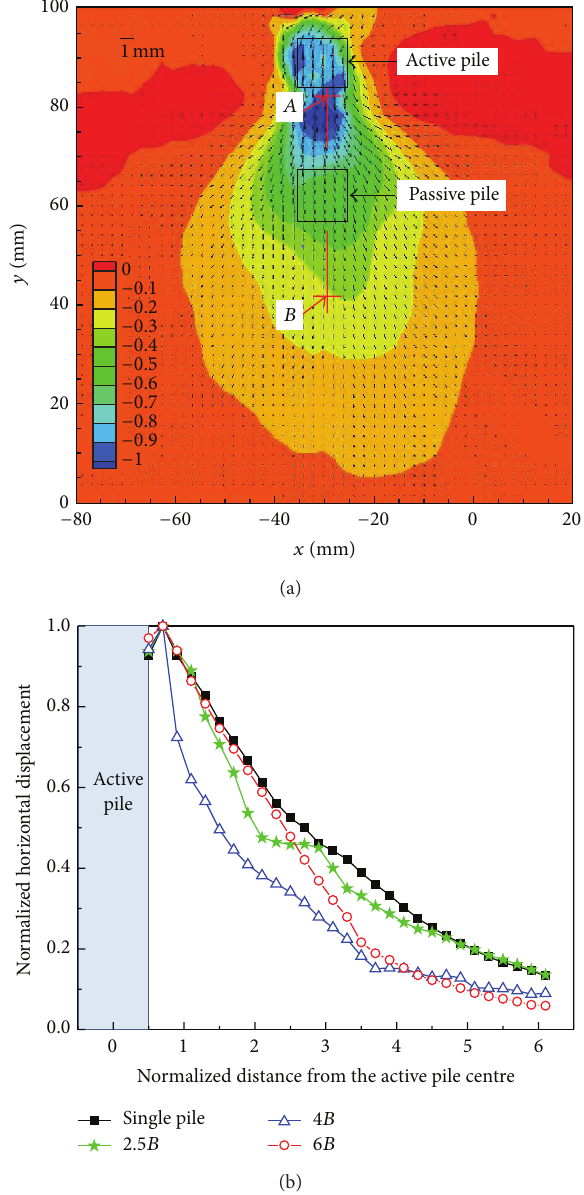
Figure 2: Horizontal displacement field: (a) 2D soil displacement field of 2.5 B pile spacing; (b) normalized horizontal displacement along the section A-B in